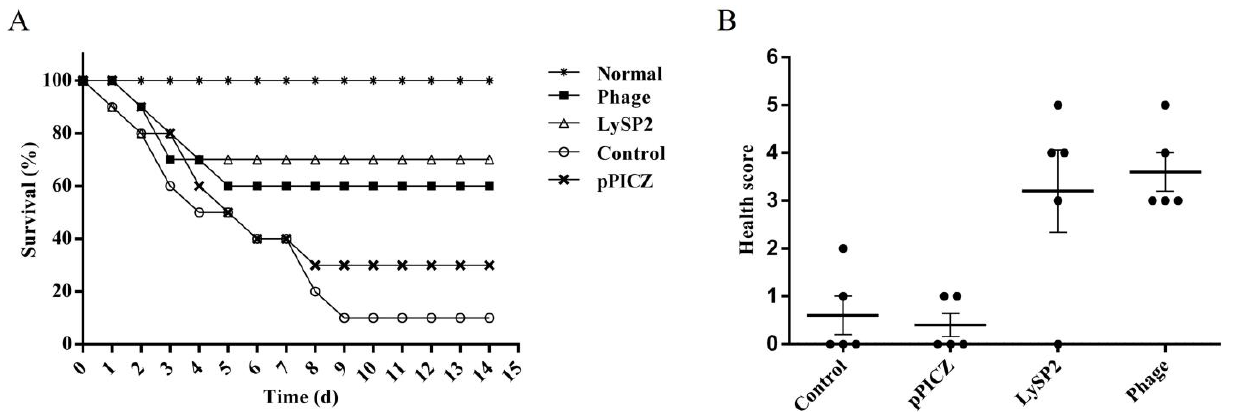
Figure 4. LySP2 improves the survival and health of infected chicks. ( A ) Chick survival rate from Salmonella pullorum infection in different groups. ( B ) Health status of Salmonella pullorum-infected chicks in different groups. Values are the mean ± SD of three determinations.